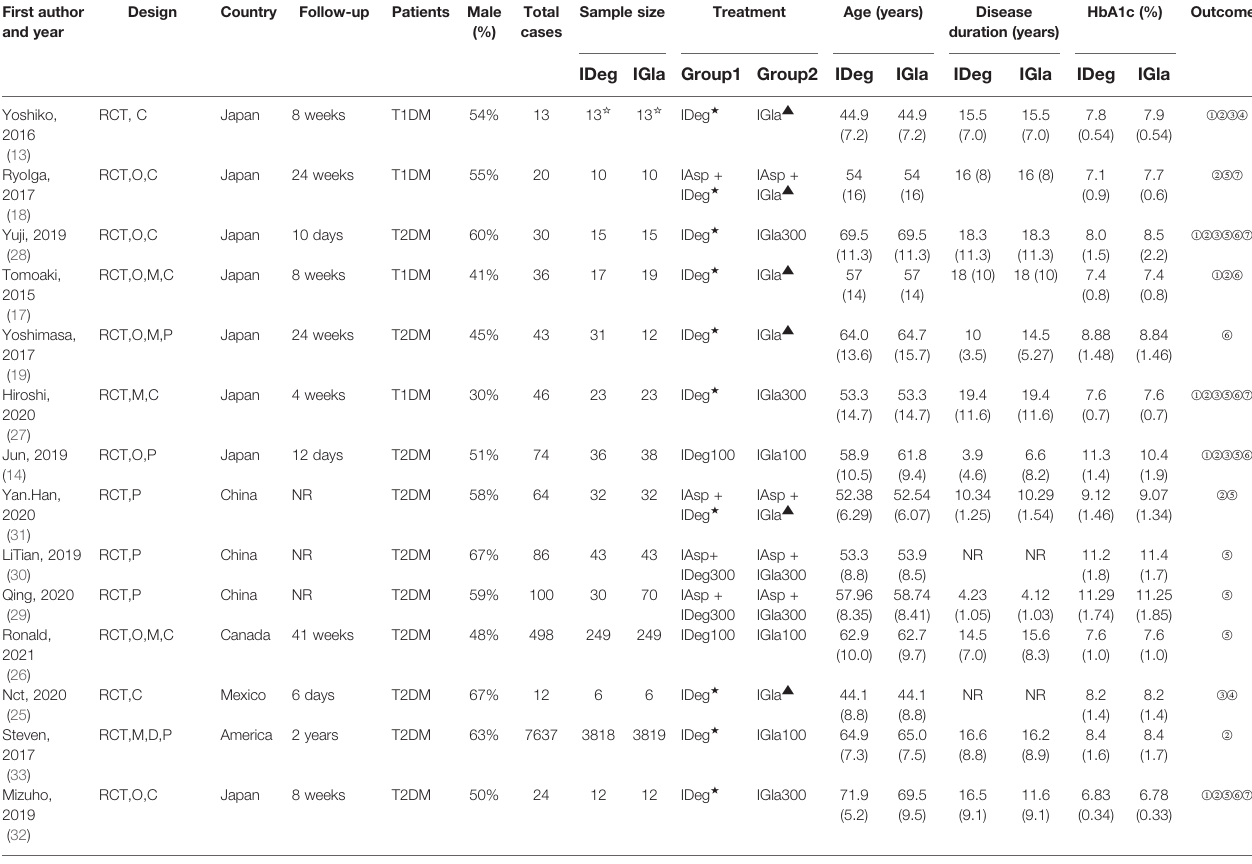
TABLE 1 | Baseline characteristics of included